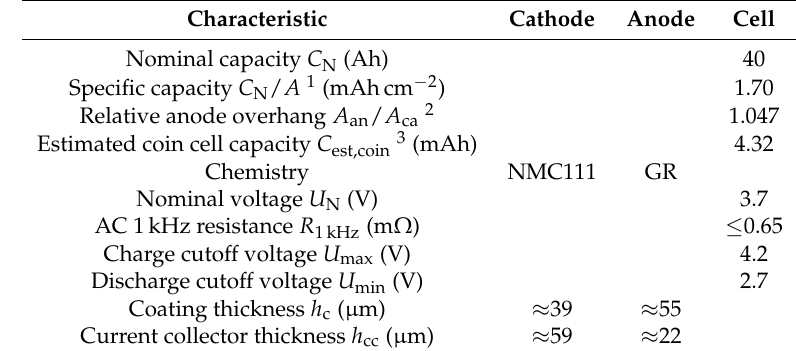
Table 2. Information about the 40Ah Li-ion pouch cell. Further information about this cell type can be found in [4,52,53].